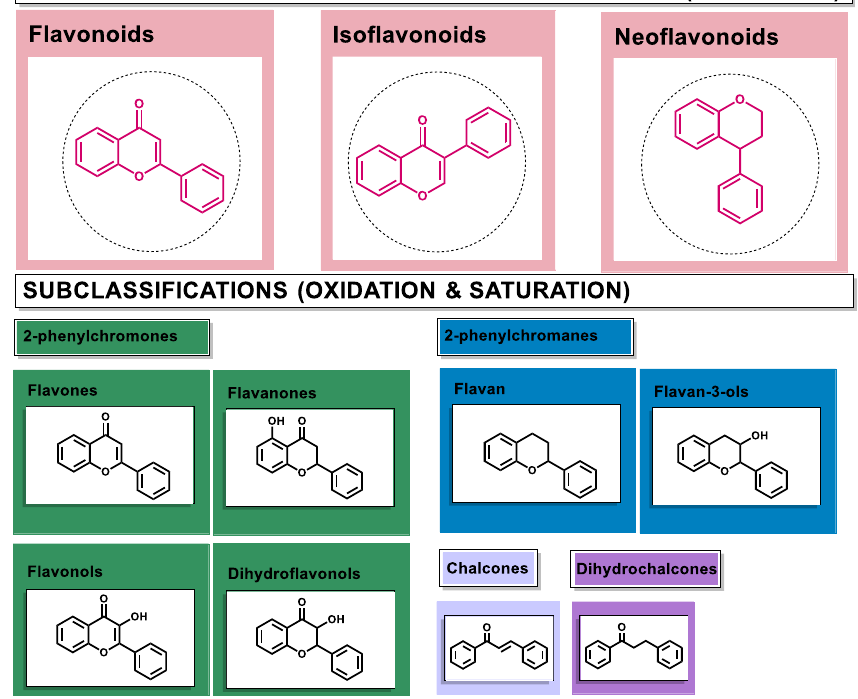
Figure 4. General classes of flavonoids and some relevant subclassifications.